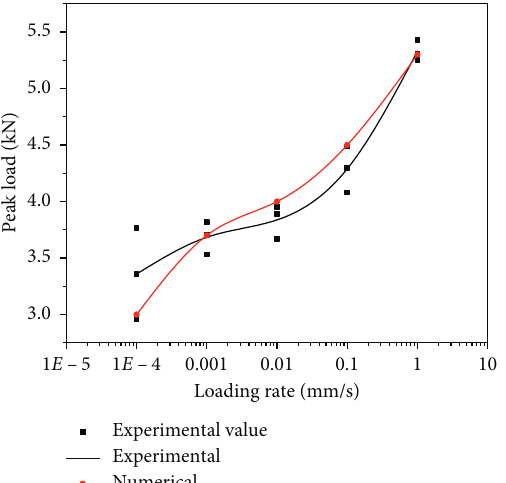
Figure 12: Comparison of the effects of loading rates on the peak load between experimental test and finite element